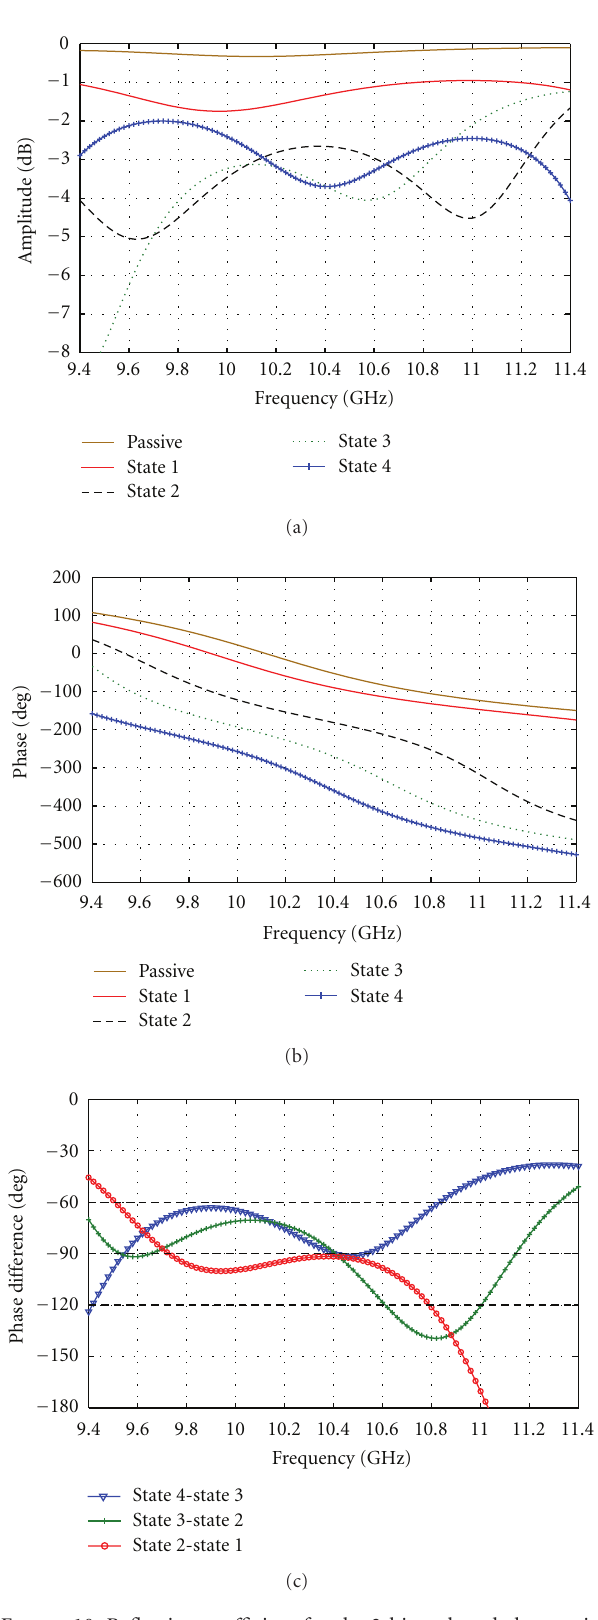
Figure 10: Reflection coe ffi cient for the 2-bit gathered element in a periodic environment. (a) Amplitude. (b) Phase. (c) Phase di ff er- ence between the adjacent states.